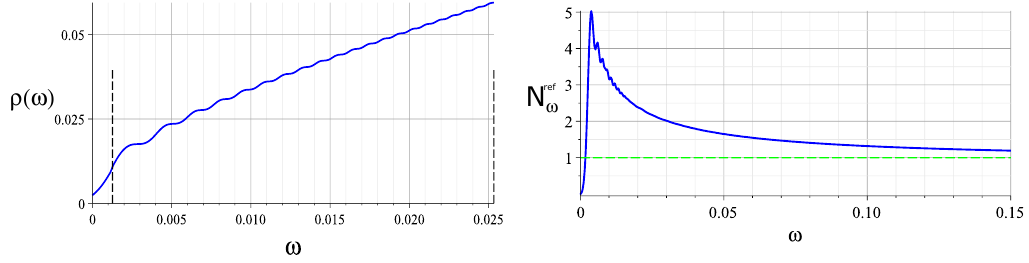
Figure 3 . (left) Spectral density ρ ( ω ) in JT gravity for any positive energy ω . The Airy answer is accurate for ω much smaller then the right dotted line. The JT gravity answer (B.7) of [11] is accurate for ω much greater then the first dotted line. (right) h 0 | N ω [ f ] | 0 i for any positive ω . The asymptotic limit (B.6) is shown